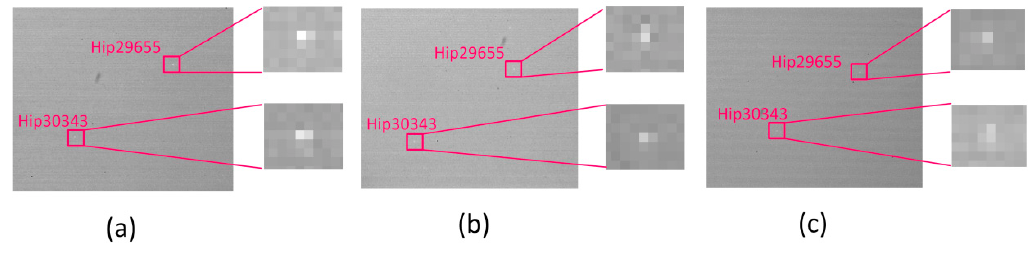
Figure 11. SWIR star images of Hip29655 and Hip30343 captured at different times. ( a ) At 7:00, ( b ) at 7:30, and ( c ) at 8:00.